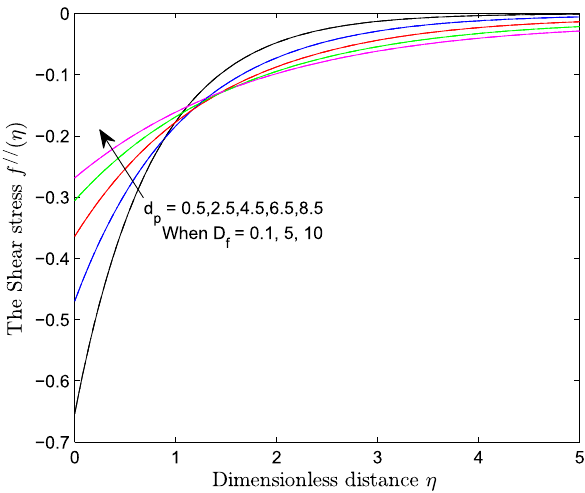
Figure 3. Variation in the velocity along y